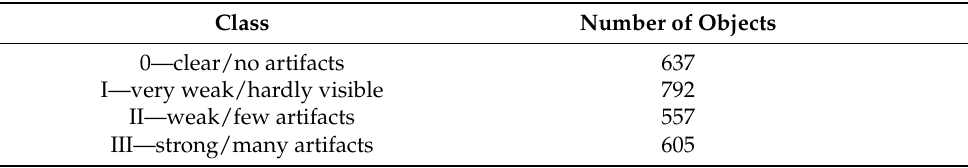
Table 1. The information about the decision